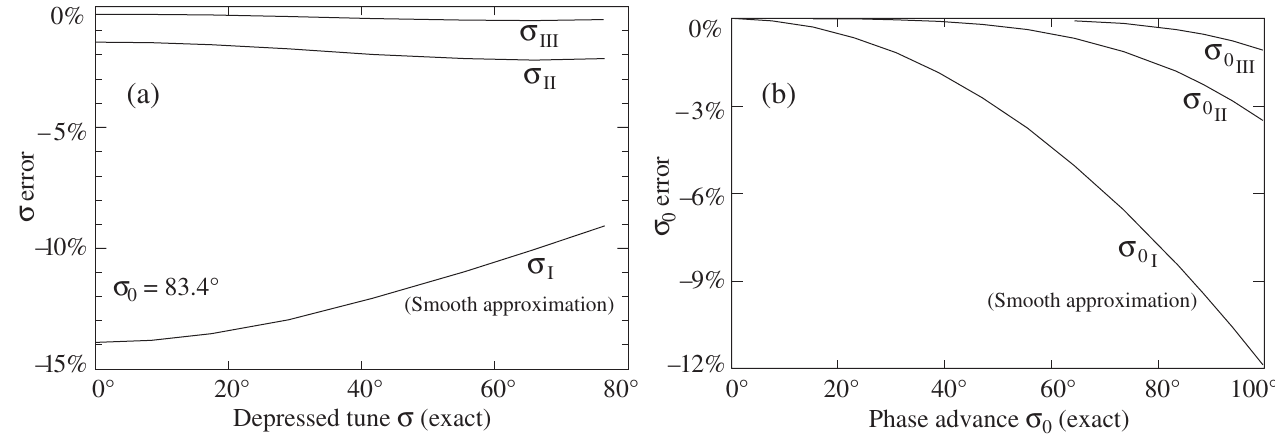
FIG. 3. Phase advances for special case of FODO model with parameters from Table II. (a) Accuracy of depressed tune (cid:2) from is fixed at 20 kV as in Fig. 1. (b) Accuracy of phase advance (cid:2) Eqs. (44)–(46). V Q